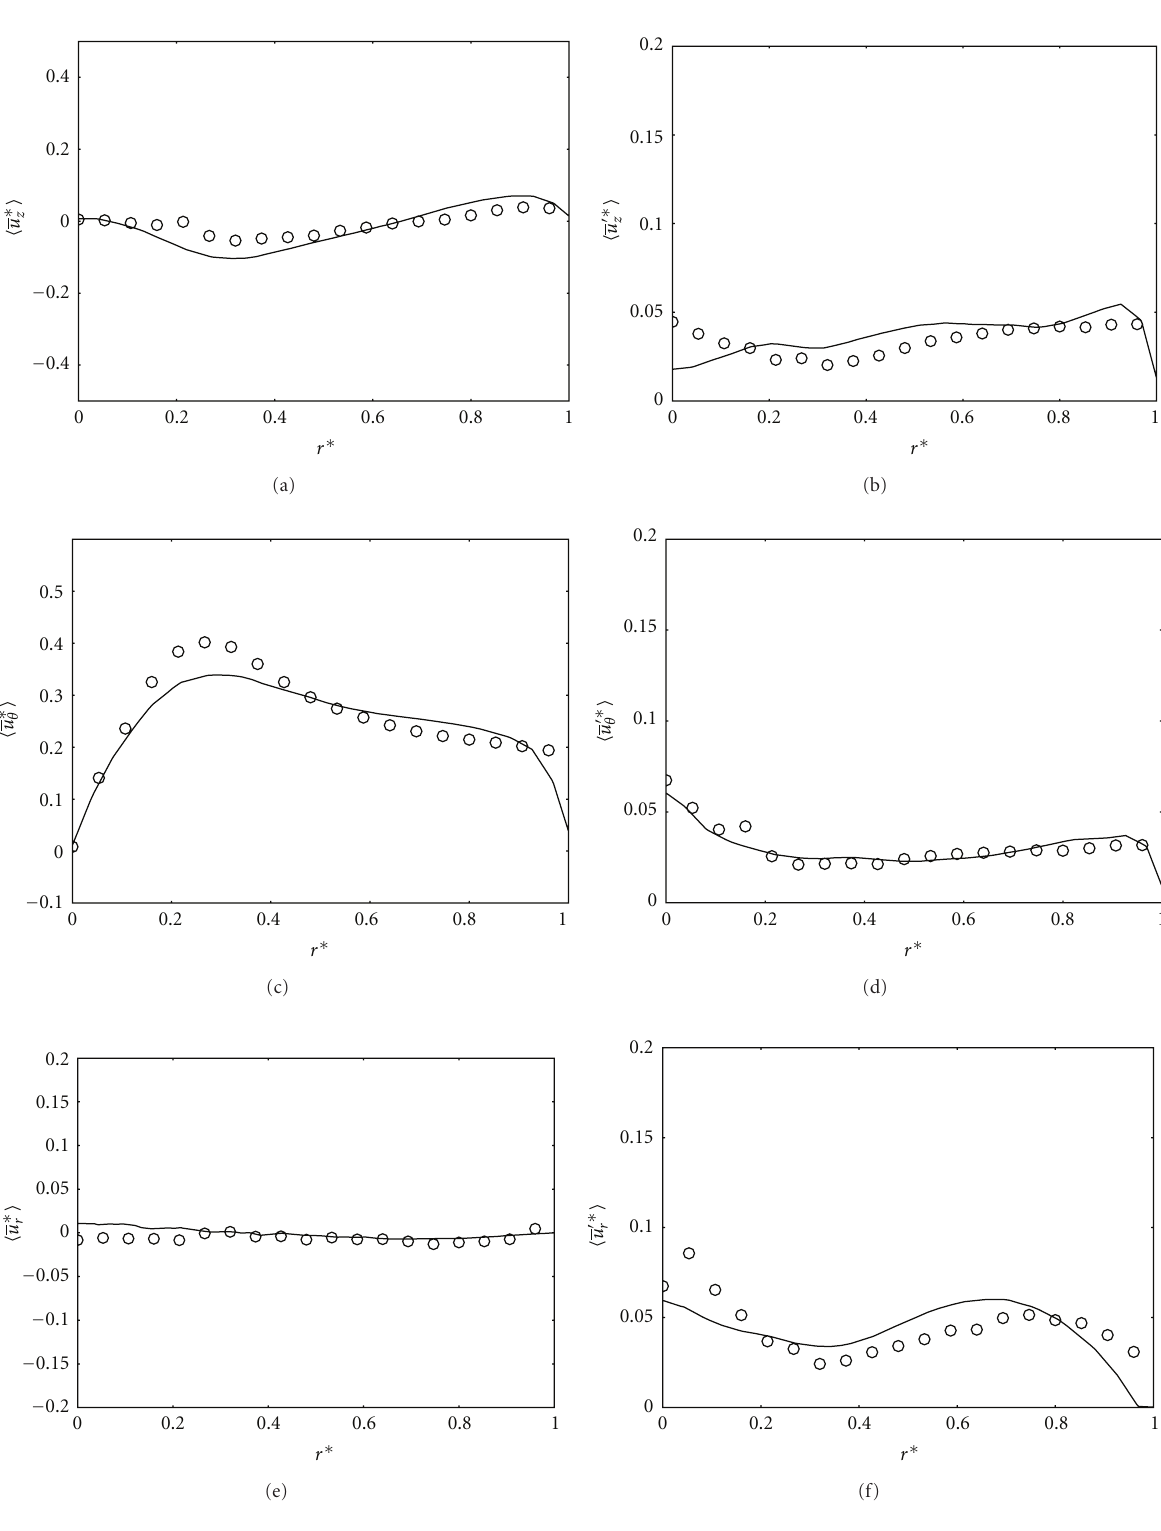
Figure 12: Mean ( u ) and fluctuating parts ( u (cid:7) ) of the velocity field along the radius at the same height z ∗ = 0 . 35. Solid lines: LES results; symbols: